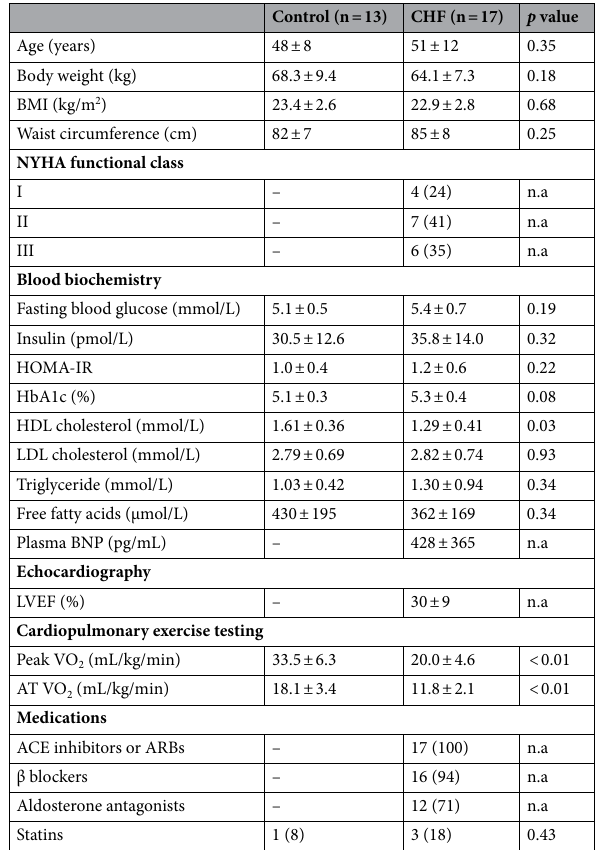
Table 1. Characteristics of the control subjects and CHF patients. Values are mean ± SD or n (%). ACE: angiotensin-converting enzyme, ARB: angiotensin II receptor blocker, AT: anaerobic threshold, BNP: B-type natriuretic peptide, HbA1c: glycohemoglobin A1c, HDL: high-density lipoprotein, HOMA-IR: homeostasis assessment model of insulin resistance, LDL: low-density lipoprotein, LVEF: left ventricular ejection fraction, n.a.: not applicable, VO 2 : oxygen